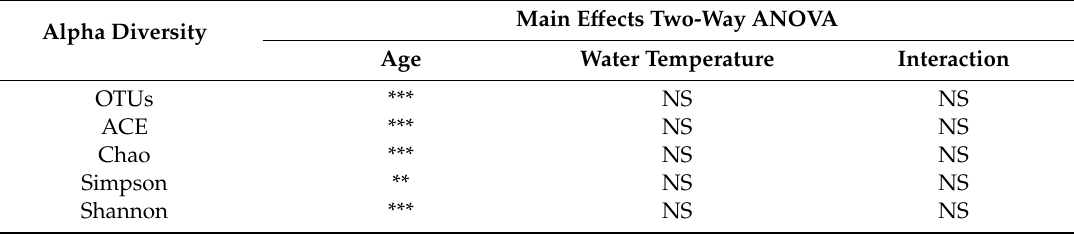
Table 3. Age-related change of richness and diversity of the cecal microbiota.